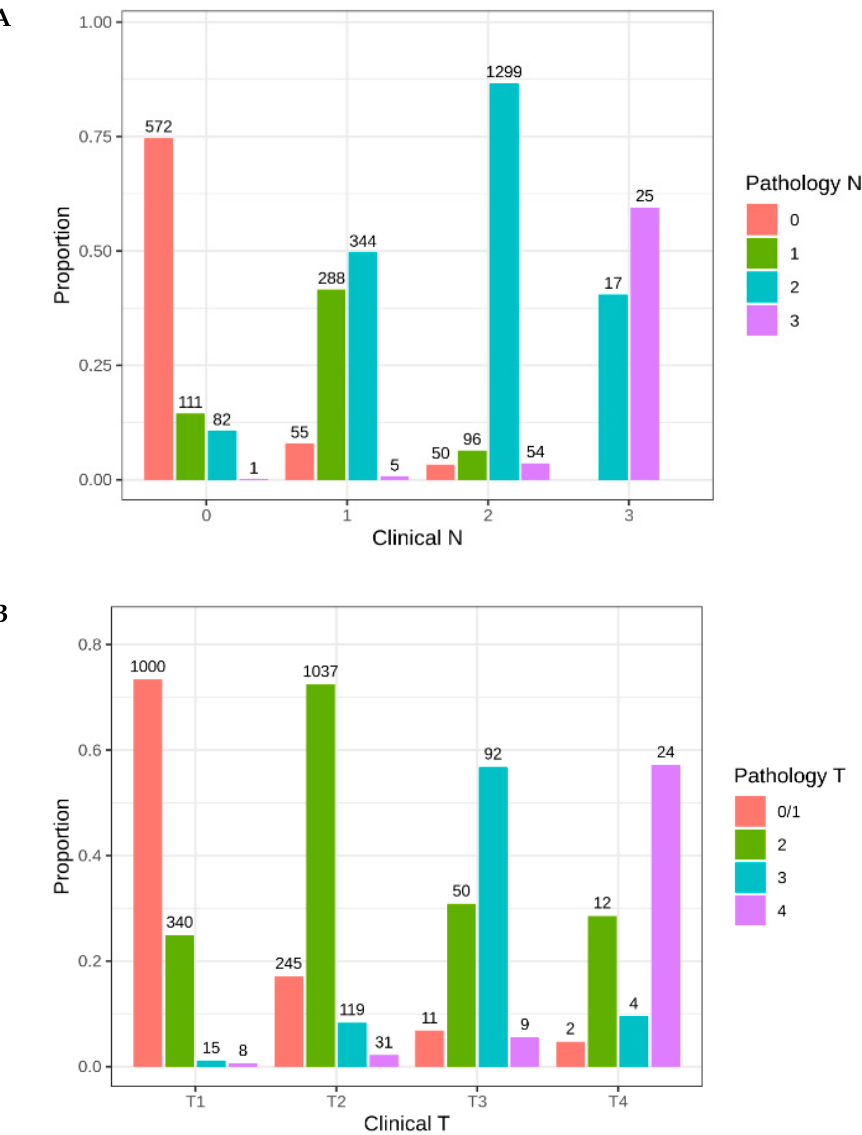
Figure 6. Change in ( A ) pathological N and ( B ) T stage after TORS surgery.